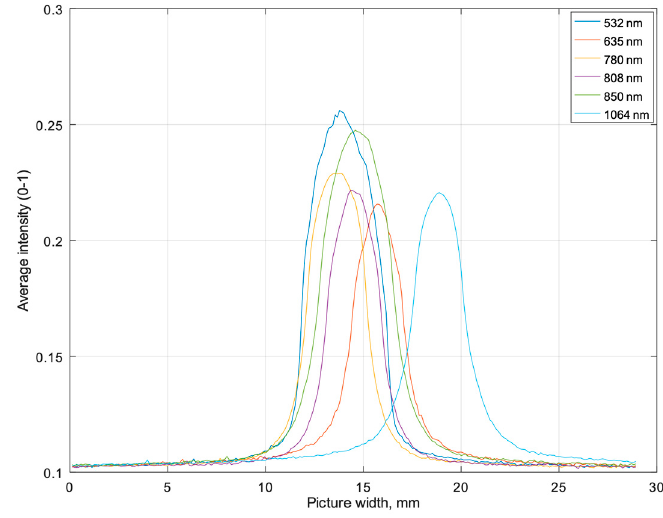
Figure 2. Intensity signals of diffuse reflectance of a selected wine sample.